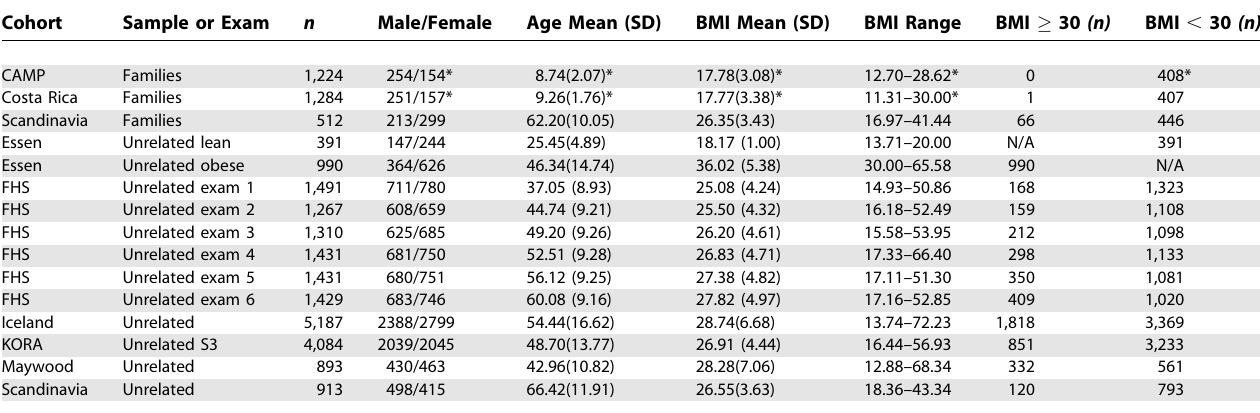
Table 1. Eight Populations ( n ¼ 16,969) Used in Association Testing of rs7566605 and Obesity/BMI